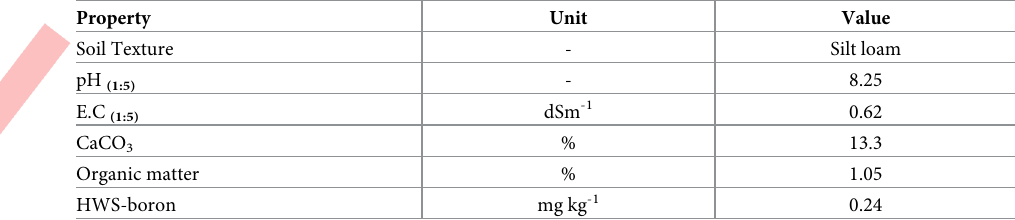
Table 1. Physico-chemical properties of the experimental